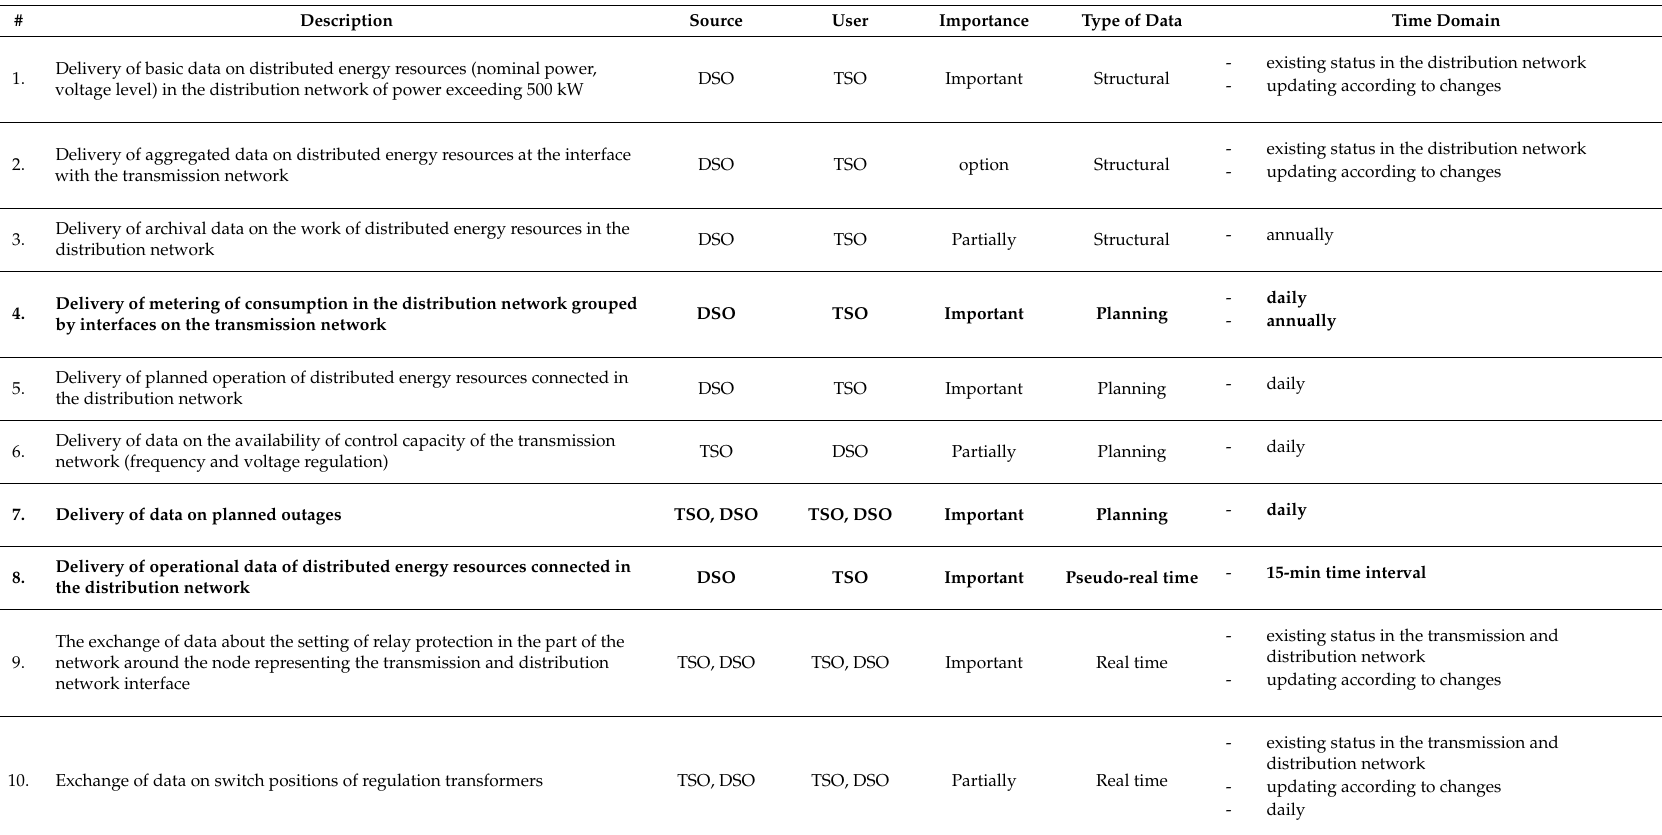
Table 1. Scheme for data exchange between TSO and